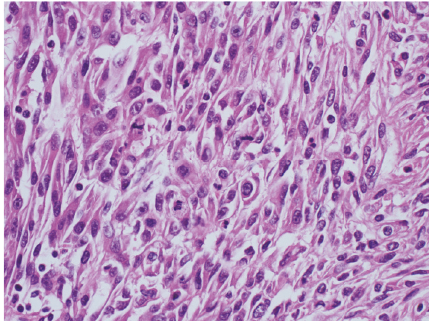
Figure 6: Higher magnification photomicrograph featuring sar- comatoid component with spindle proliferation, nuclear pleomor- phism, and increased mitotic activity.